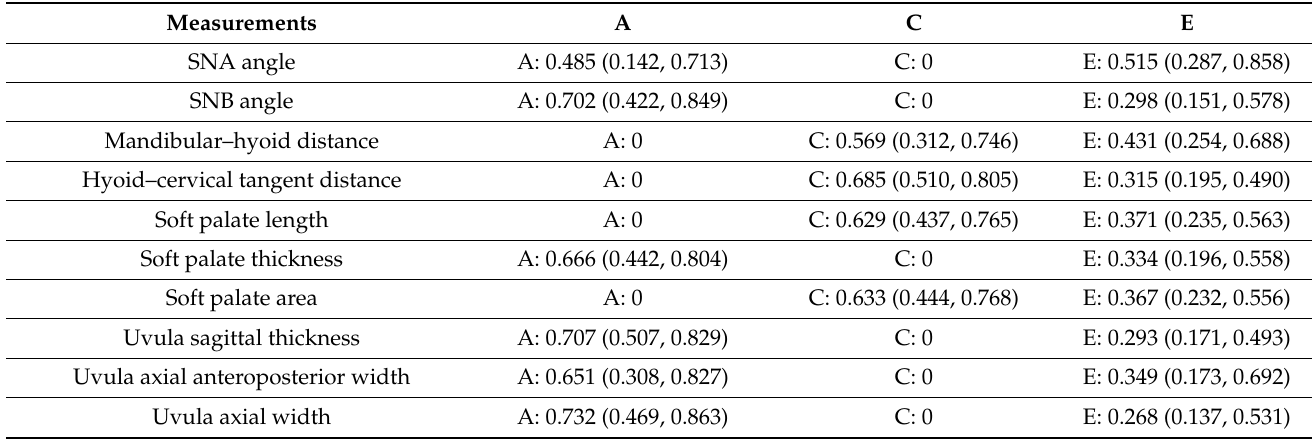
Table 2. ACE models of the measured anatomical markers with 95% confidence interval after defining the best fitting sub-model. A: additive genetics, C: common environment, E: unique environment.